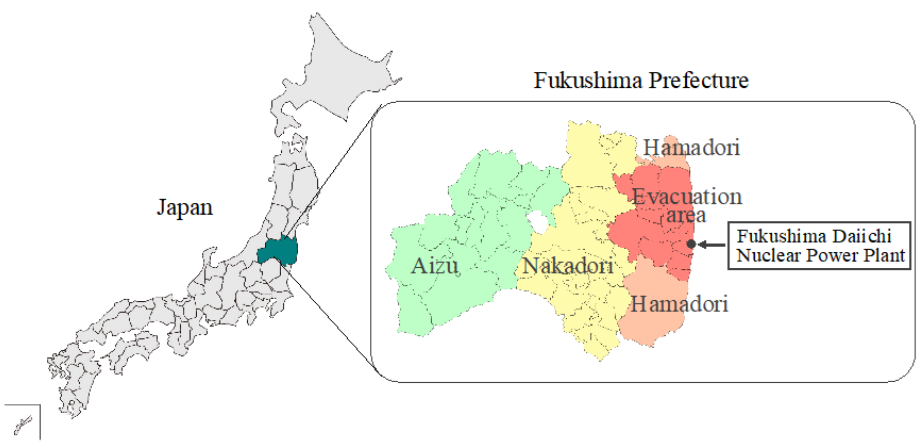
Figure 2. Regional Classification in Fukushima Prefecture.